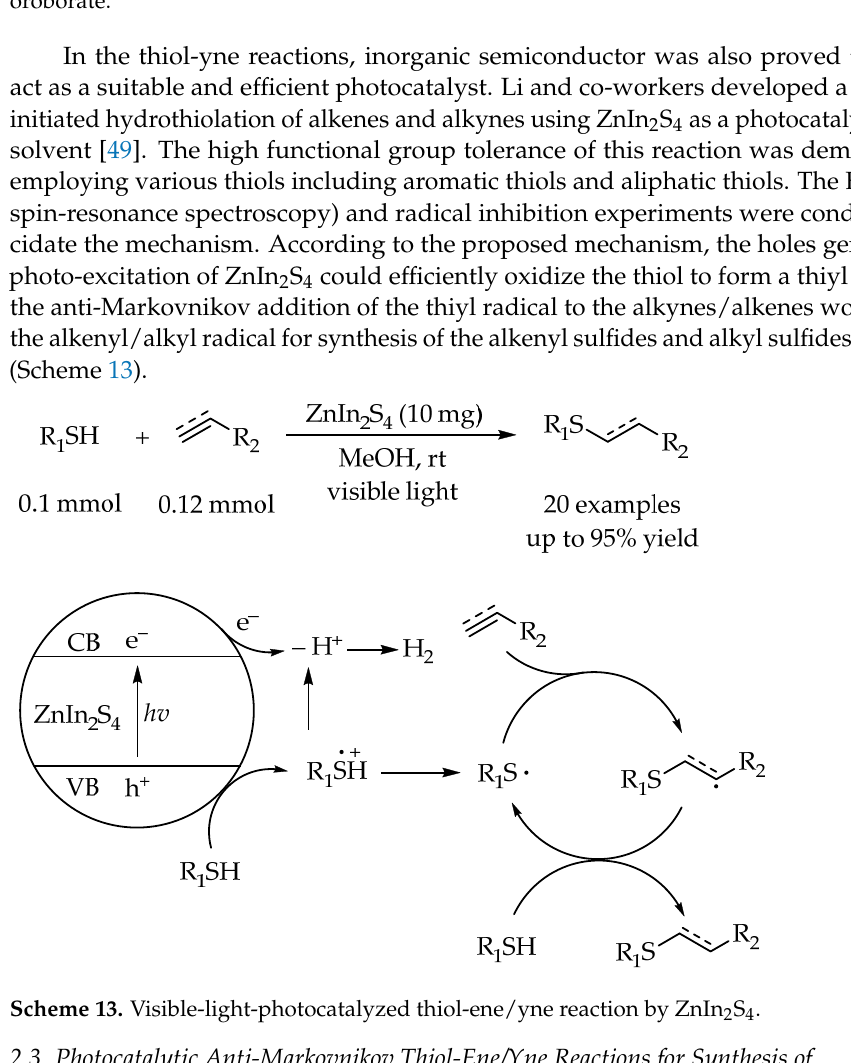
Scheme 12. Visible ‐ light ‐ photocatalyzed thiol ‐ yne reaction by 9 ‐ mesityl ‐ 10 ‐ methylacridinium